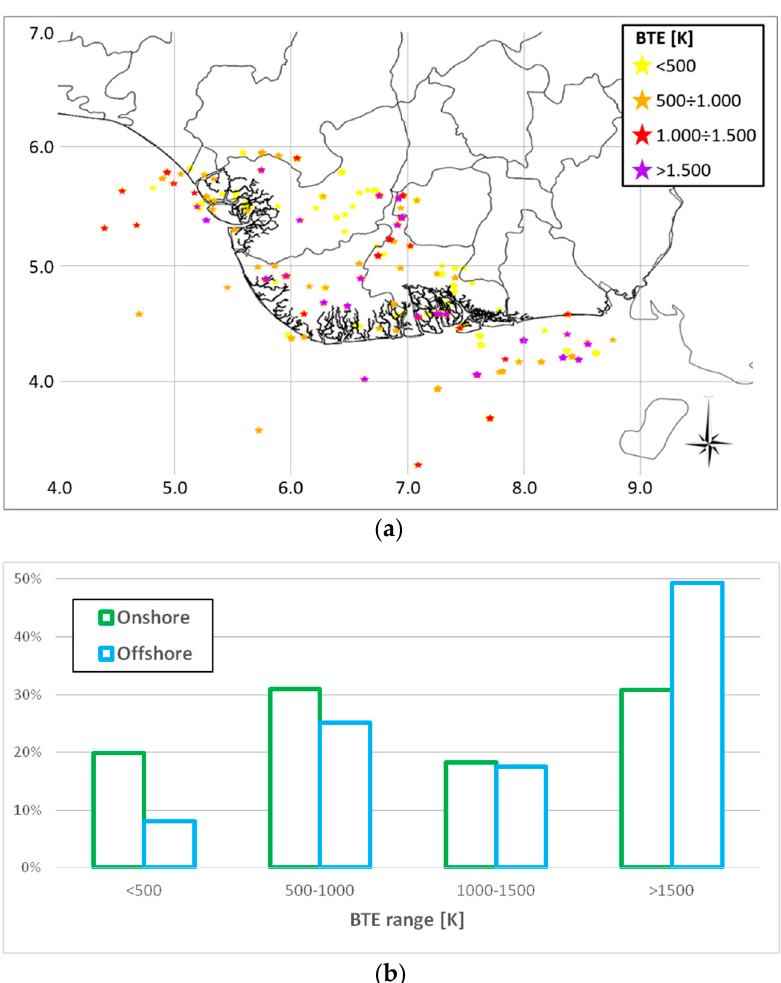
Figure 8. ( a ) Spatial distribution of BTE classes in the investigated states, ( b ) distribution of BTE classes between onshore and offshore. Table 2. Regression models